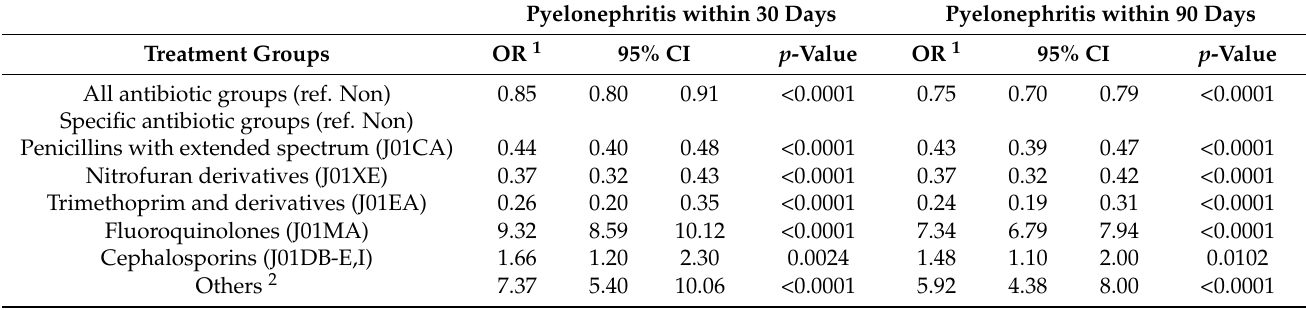
CI: confidence interval. OR: odds ratio. Nationwide primary healthcare data were used to identify the study population of women with uncomplicated cystitis. The Swedish Prescribed Drug Register was used to identify antibiotic treatment groups. Nationwide primary healthcare data and the National Patient Register (outpatient data) were used to identify pyelonephritis. 1 Fully adjusted for history of cervical cancer and parity and individual